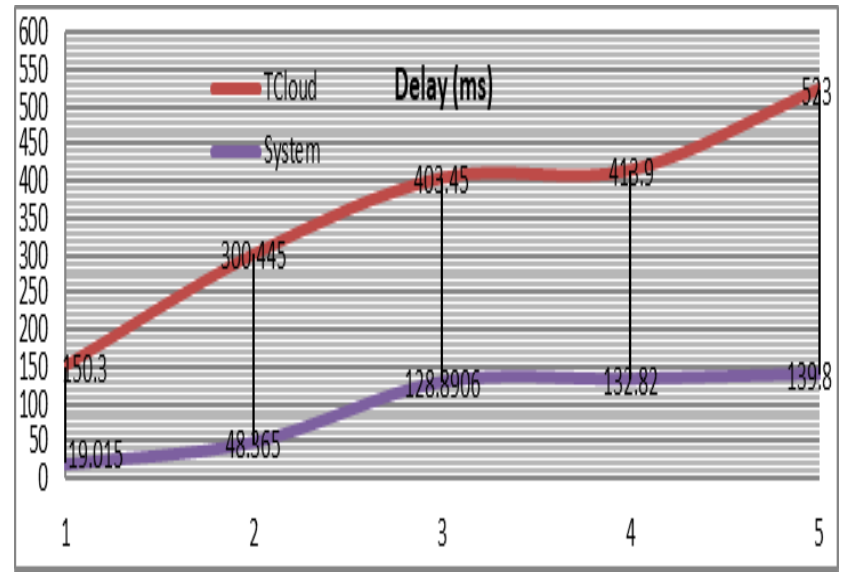
Figure 11. Delay factor in MAFC and Cloud datacenters .